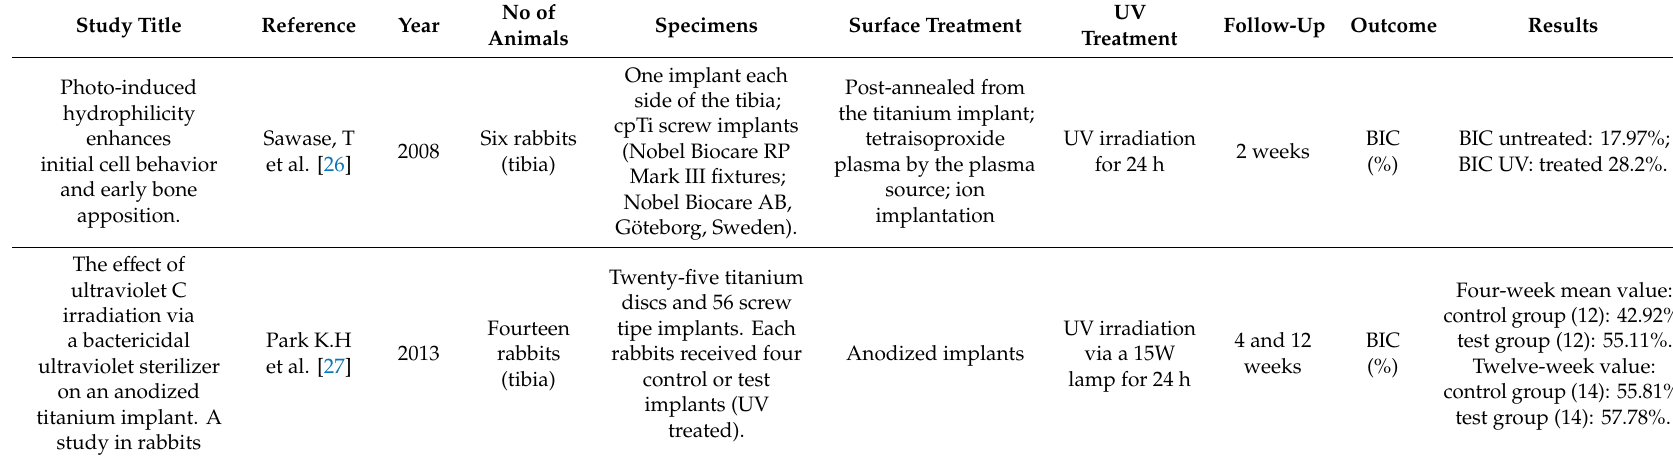
Table 2. Main characteristics and outcome of included studies about